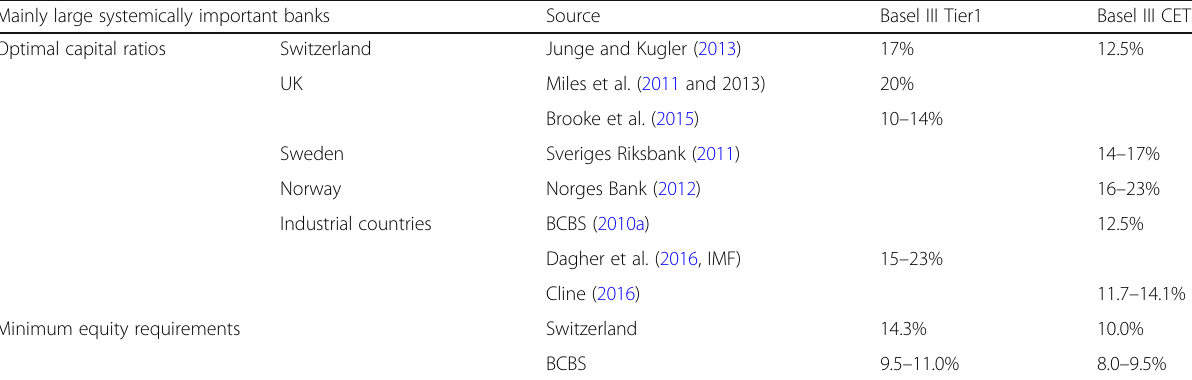
Table 7 Optimal capital ratios and minimum equity requirements Mainly large systemically important banks